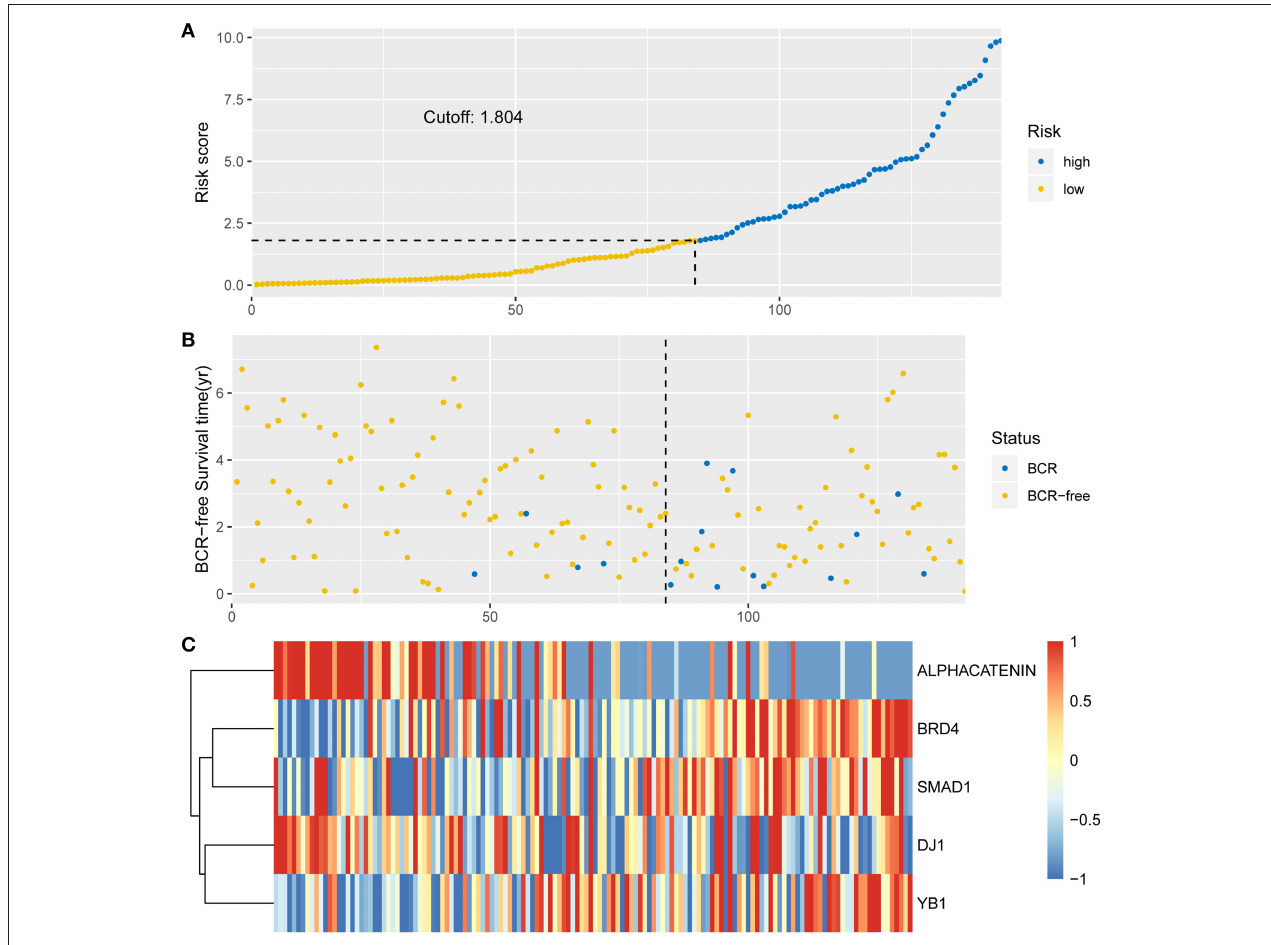
FIGURE 2 | Identification of the integrated prognostic classifier in the training set. (A) The distribution of risk score. The median risk score cut-off is 1.804. (B) Each point in the scatterplot represents the survival status of patients. (C) Heat map showed differentially expressed proteins between BCR-free patients and patients with